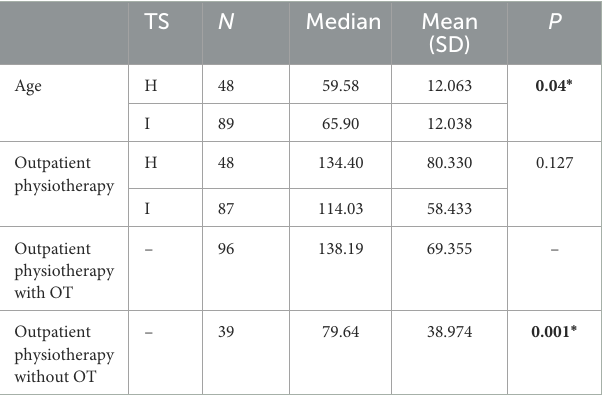
TABLE 3 Correlation of the number of outpatient physiotherapy sessions performed for each stroke type with “age” and “occupational therapy” (Student’s t -test).